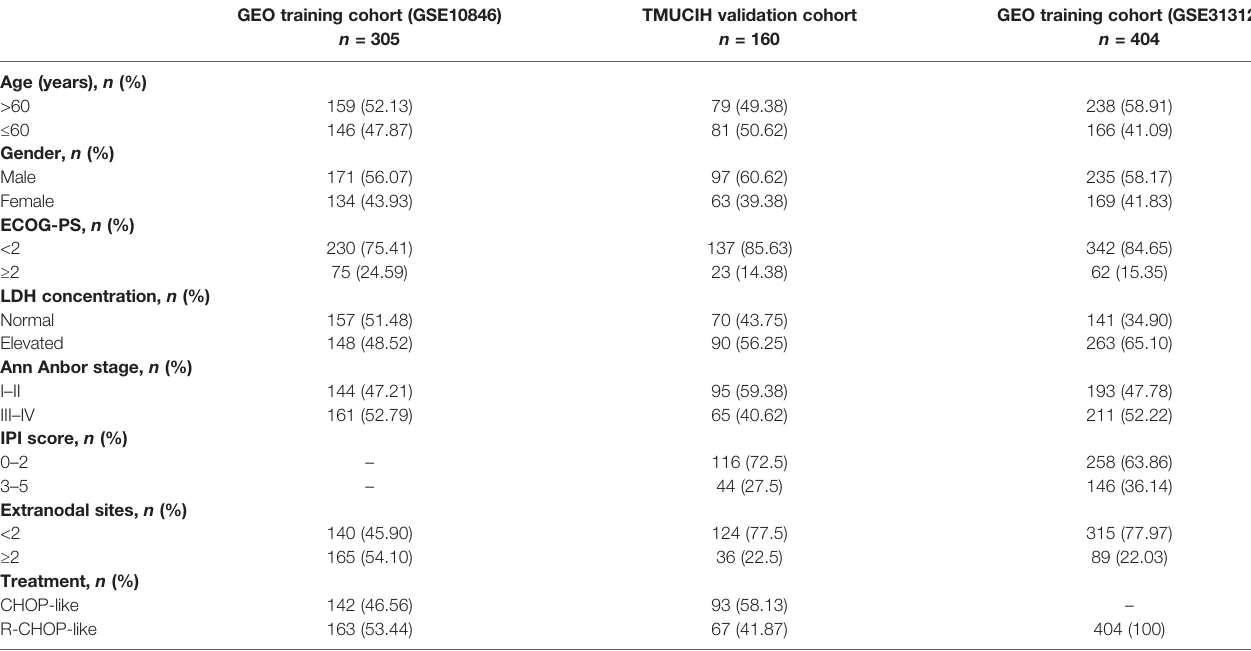
TABLE 1 | Demographic and baseline characteristics of patients enrolled to construct and validate the epigenetic risk